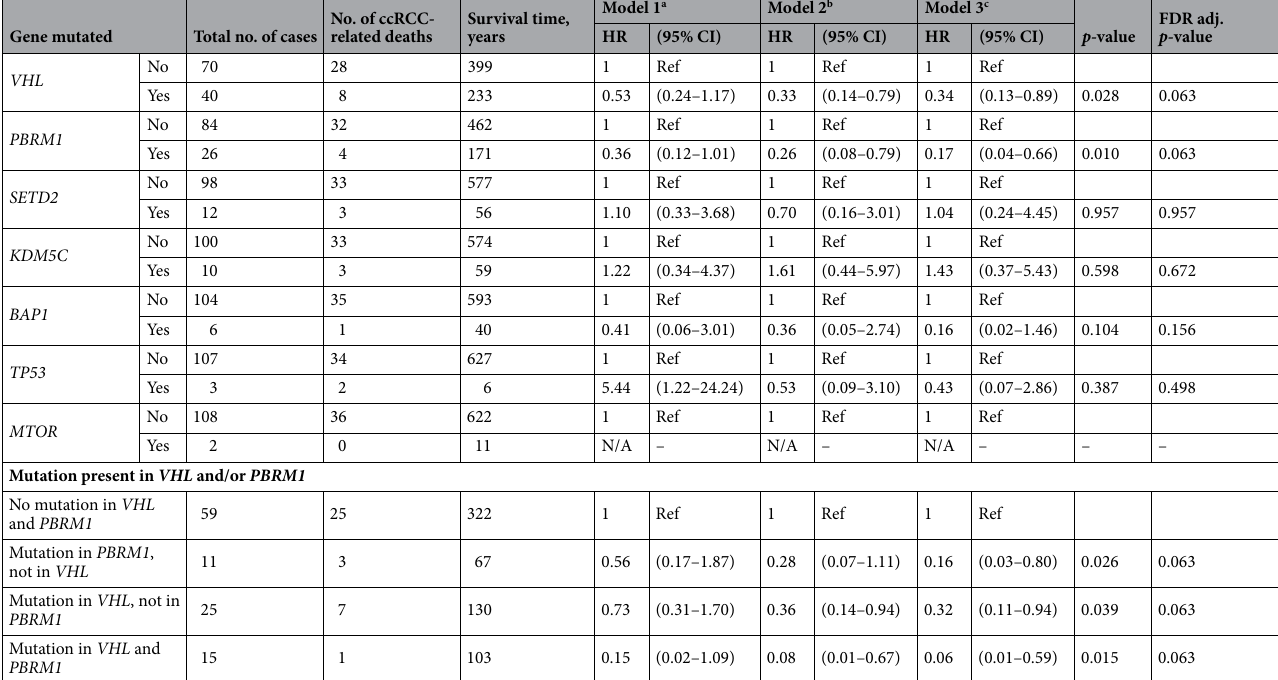
Table 3. Hazard ratios (HRs) for ccRCC-related deaths truncated at 10 years of follow-up according to genotypes of ccRCC in the Netherlands Cohort Study on diet and cancer. The FDR-adjusted p -value was calculated using the Benjamini–Hochberg method. The cut-off for a statistically significant p -value and FDR- adjusted p -value is 0.05. a Adjusted for age at diagnosis (years) and sex. b Adjusted for age at diagnosis (years), sex, TNM stage, differentiation grade and tumour size. c Adjusted for age at diagnosis (years), sex, TNM stage, differentiation grade and tumour size and mutually adjusted for the other genes. MTOR was not included in the model due to the absence of fatal events in participants with an MTOR